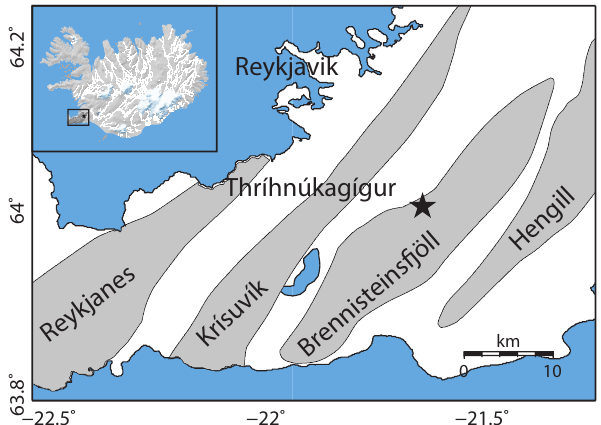
Figure 1: Map of the approximate boundaries of the four main volcanic systems of the Reykjanes Peninsula and the location of Thríhnúkagígur in the Brennisteinsfjöll system [Einarsson and Sæmundsson 1987]. The map corresponds to the box in the inset map of